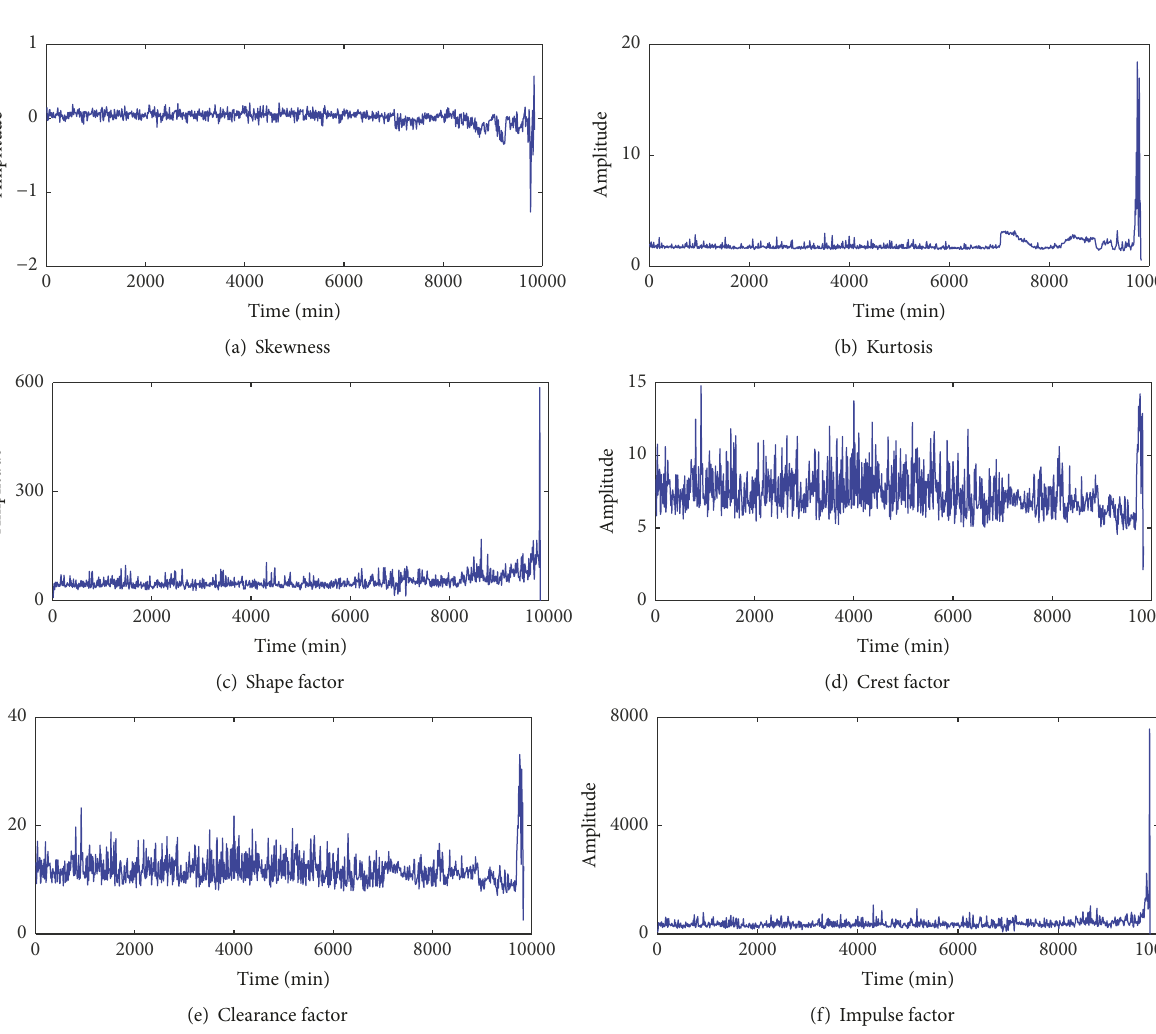
Figure 5: Six dimensionless time domain